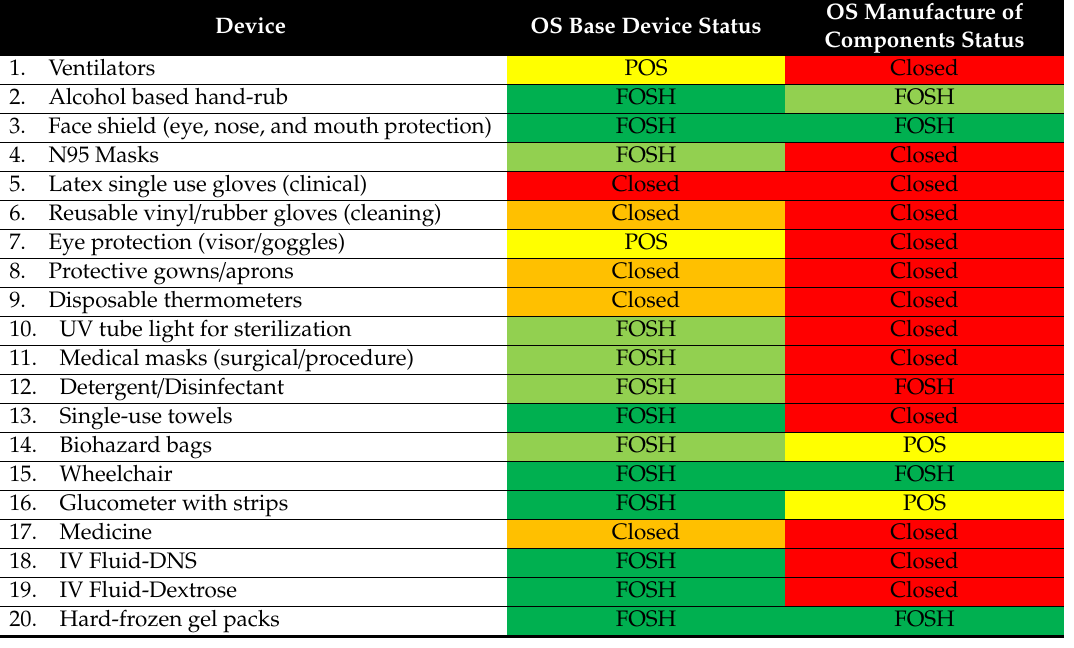
Table 1. Summary of open source development status of India’s top 20 requested medical supplies and their method of manufacture of components during the COVID-19 pandemic. Dark green indicates FOSH completed, light green indicates FOSH with near full documentation, yellow means POS, orange indicates some open source tools are available, but primary plans are closed, and red indicates closed